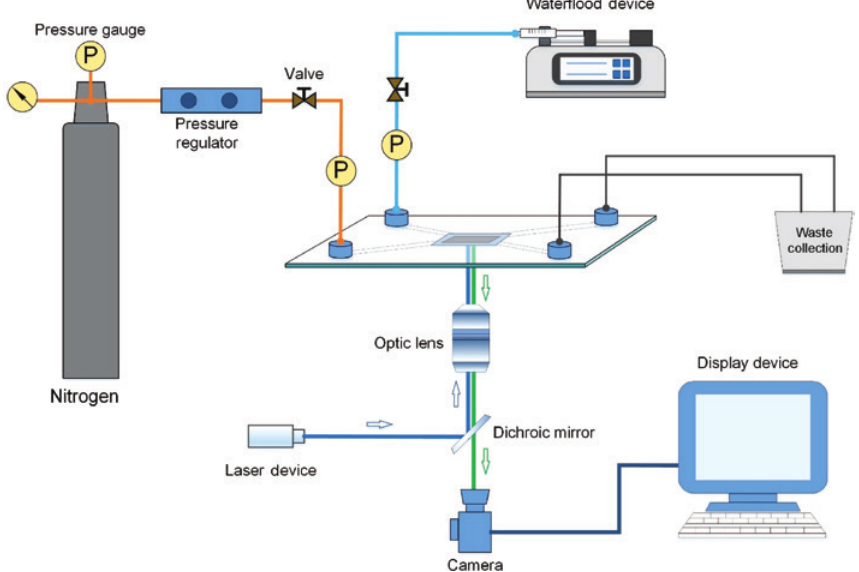
Figure 1: Optical imaging apparatus